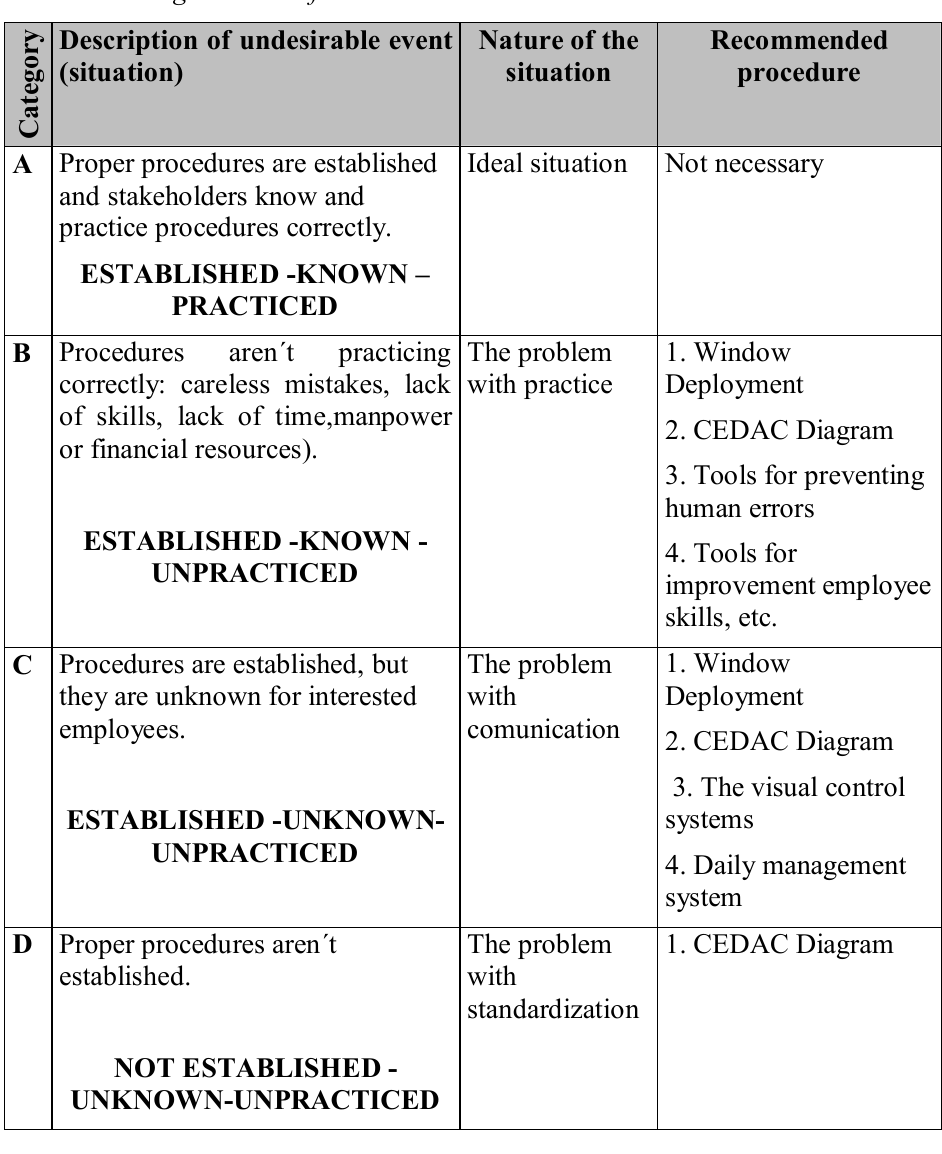
Nature of the situation